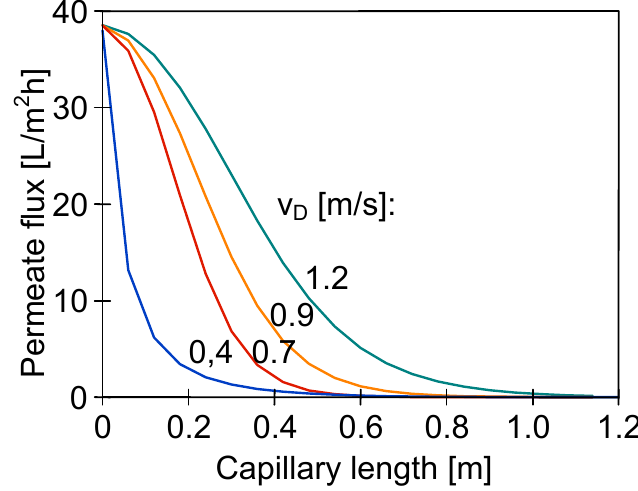
Figure 13. The influence of distillate flow rate on the distribution of the permeate flux along the module length. Mode 1. T F = 343 K. Membranes PV370.